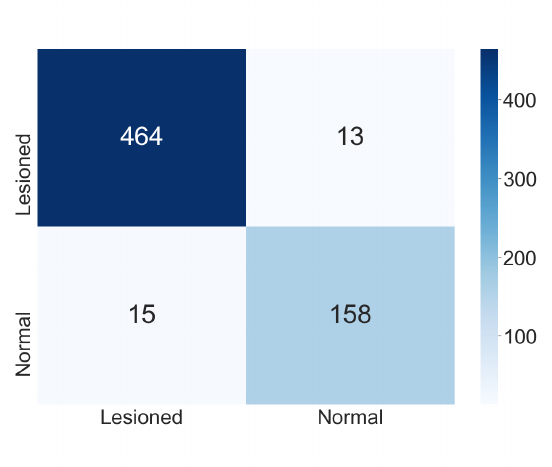
Figure 5. Confusion matrix for the two-class classification.